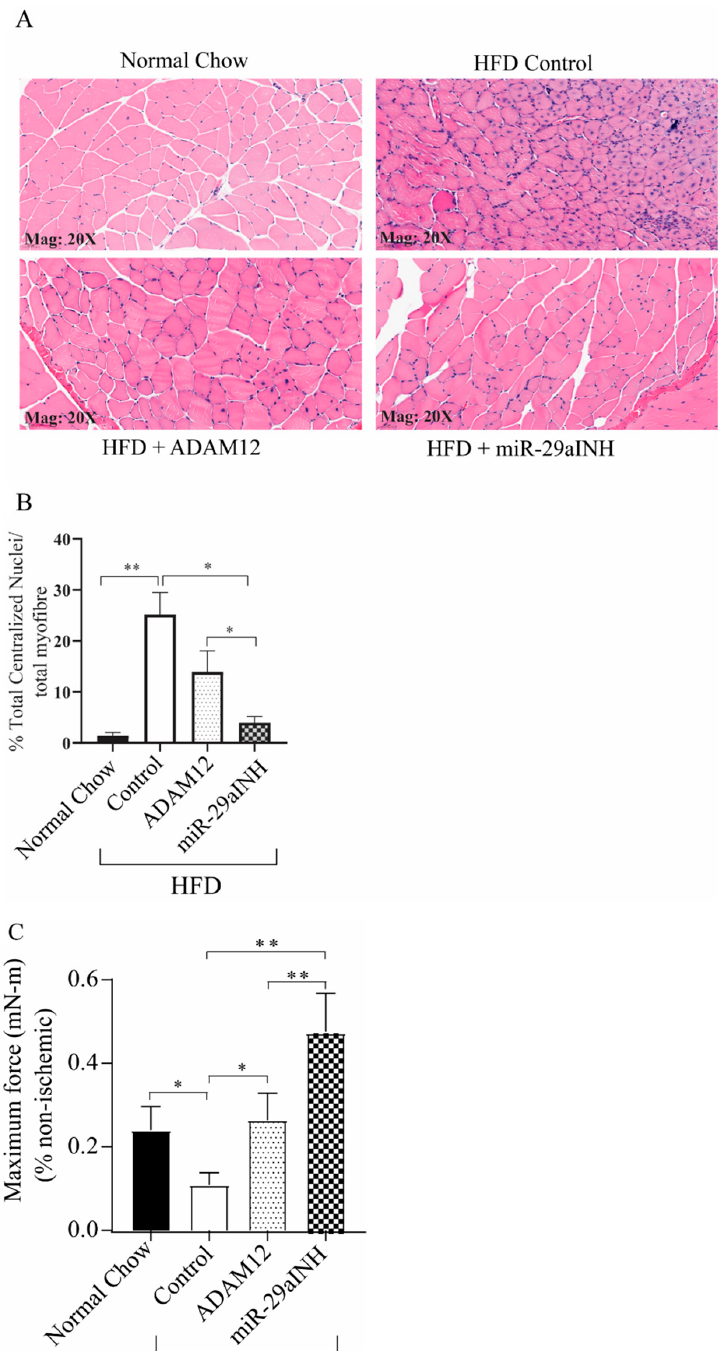
Figure 4. ADAM12 augmentation and miR-29a inhibition reduced the extent of skeletal muscle injury and increased skeletal muscle function in post-ischemic GA muscle of HFD mice. Sections from normal chow, HFD, HFD + ADAM12, and HFD + miR-29aINH treated animals were subjected to immunohistostaining using H&E (for morphology analysis). ( A ) Representative images of H&E- stained sections of day 21 ischemic GA muscle showing centrally located nuclei in muscle fibers. ( B ) Quantification of skeletal muscle injury as determined by the percentage of total number of muscle fibers with centrally located nuclei (* p < 0.05, ** p < 0.005, n = 4/group scale bar = 20X). ( C ) Muscle function analysis as assessed by maximum muscle contraction on 21 days post-ischemic mouse GA muscle (* p < 0.05, ** p <0.005 and Normal Chow: n = 6, HFD Control: n = 6, HFD + ADAM12: n = 7 and HFD + miR29aINH: n = 8).